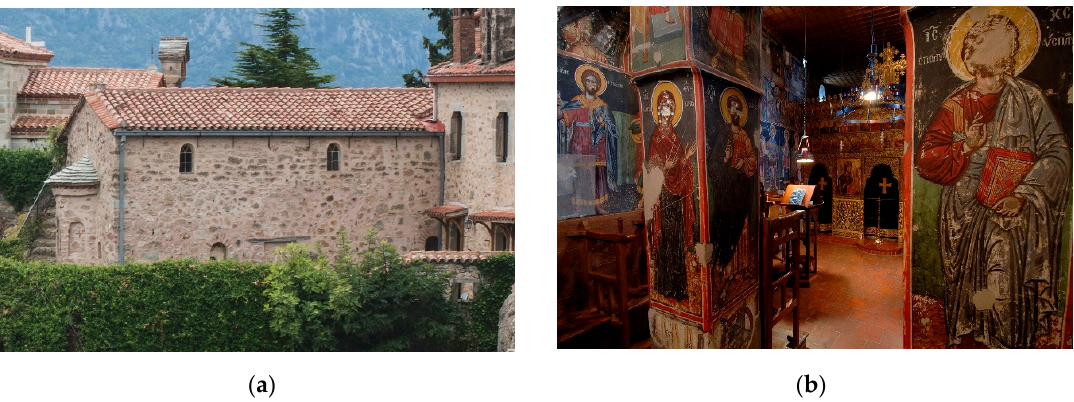
Figure 4. The old catholikon of the Monastery of St. Stephen: ( a ) Exterior; ( b ) Part of the nave where the full-length figures of Saints and Jesus are distinct. In the back the iconostasis that separates the nave from the sanctuary is distinguished. nave from the sanctuary is distinguished.